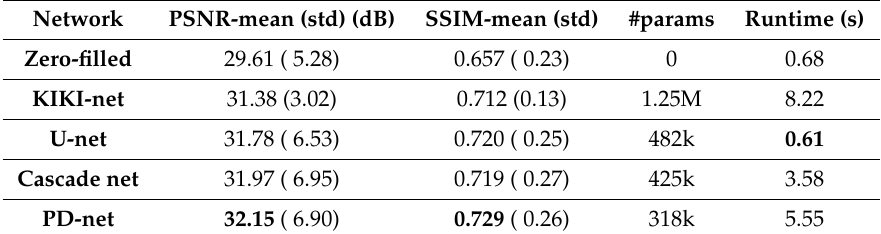
Table 1. Quantitative results for the fastMRI dataset. Peak Signal-to-Noise Ratio (PSNR) and Structural SIMilarity index (SSIM) mean and standard deviations are computed over the 200 validation volumes. Runtimes are given for the reconstruction of a volume with 35 slices.